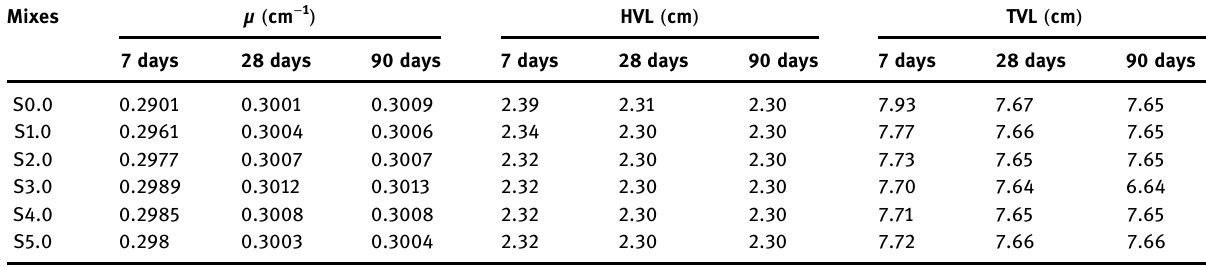
Table 4: Relationship between HVL, TVL, and µ of SSHWC mixes subjected to γ - Ray Mixes